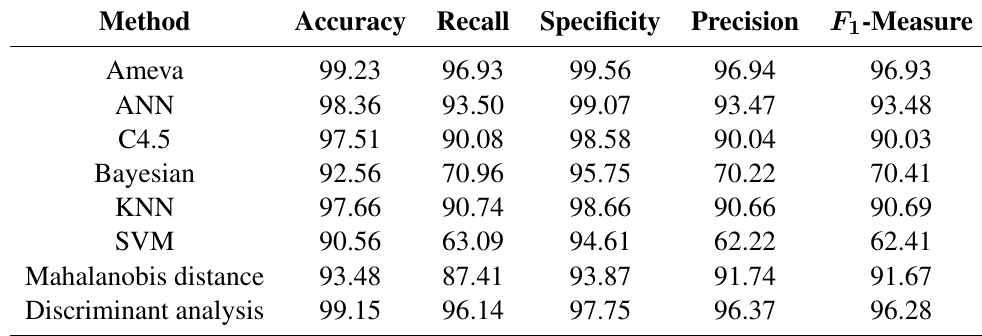
Table 7. Performance comparison in % by using measures of evaluation.